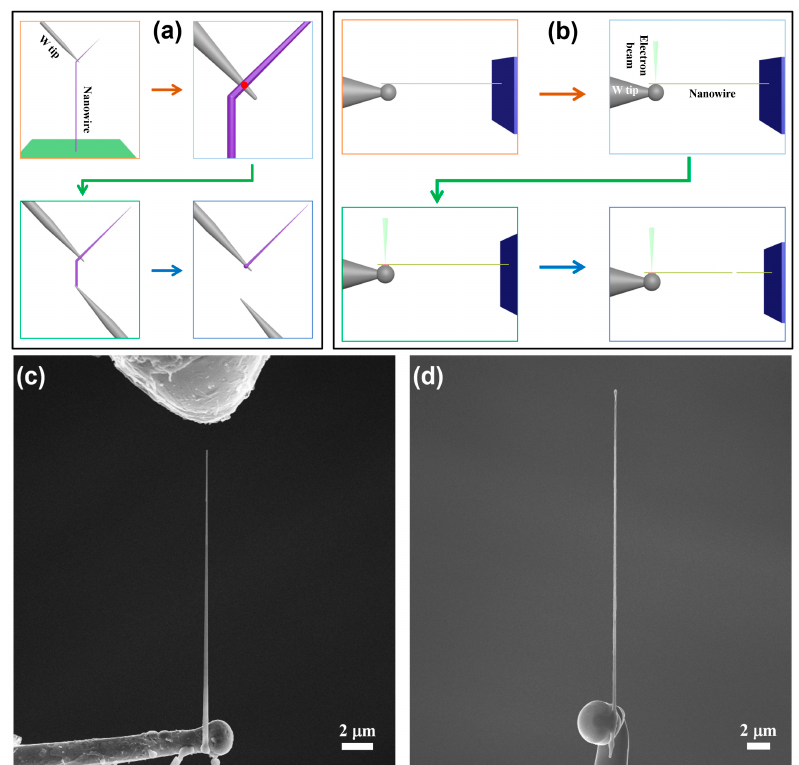
Figure 1. ( a ) Schematic diagram of the detailed nanostructure welding process in perpendicular orientation (red-spot area is the position of electron-beam irradiation). ( b ) Schematic diagram of the detailed nanostructure welding process in parallel orientation. ( c ) SEM image of an individual LaB 6